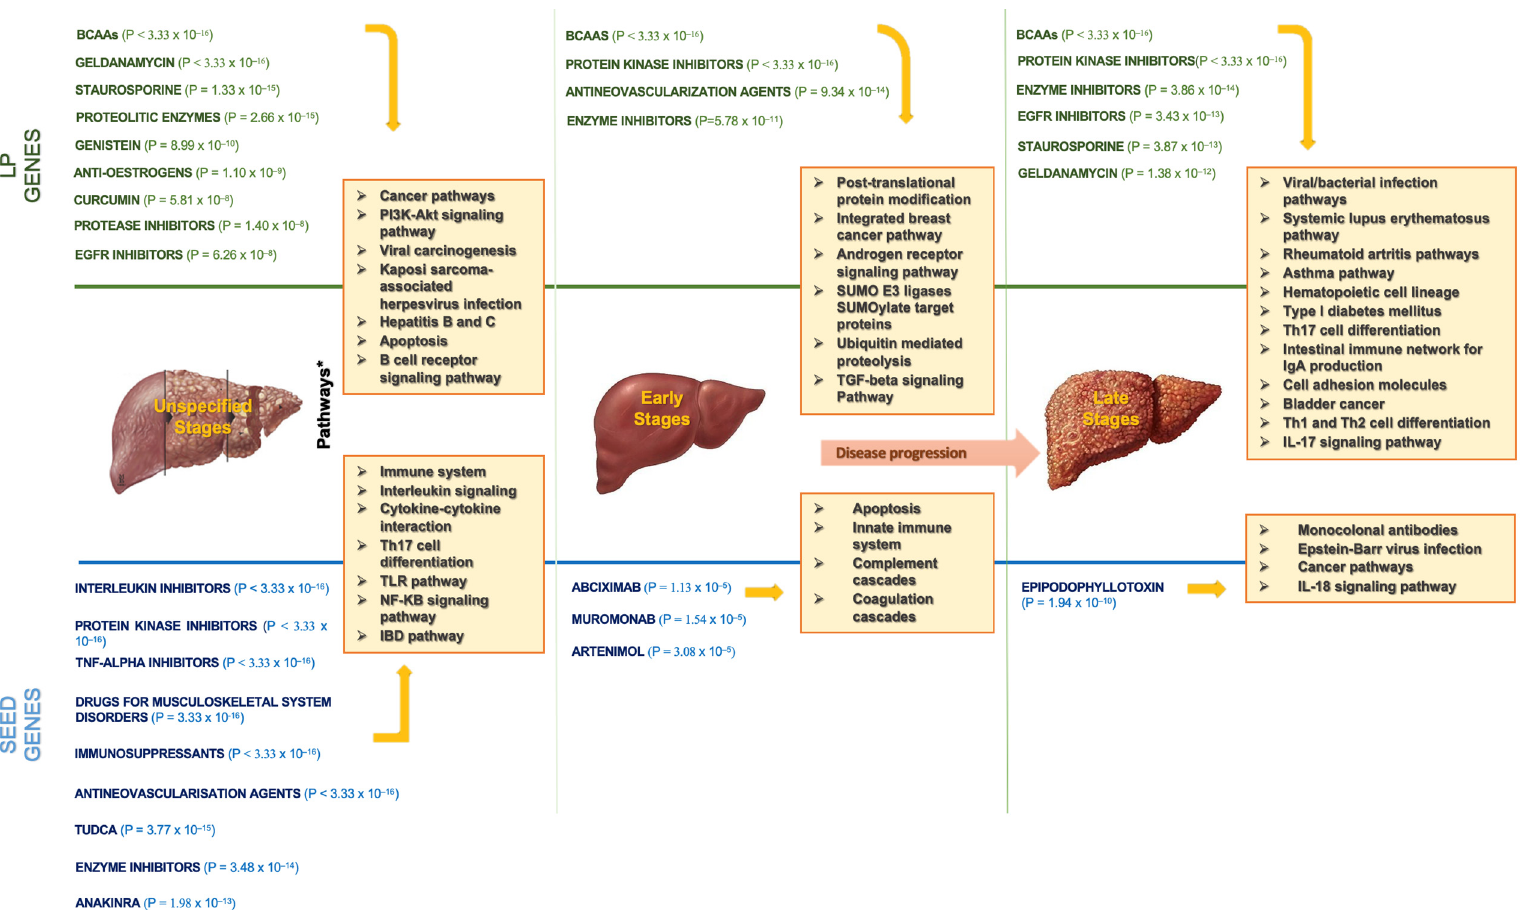
Figure 5. The most enriched drugs and pathways found in LP and seed genes. BCAAs: branched-chain amino acids; EGFR: epidermal growth factor receptor; TNF: tumor necrosis factor; TUDCA: tauroursodeoxycholic acid; TLR: Toll-like receptor; IBD: inflammatory bowel disease.; SUMO: small ubiquitin-like modifier; TGF: trasforming growth factor; IL: interleukin.